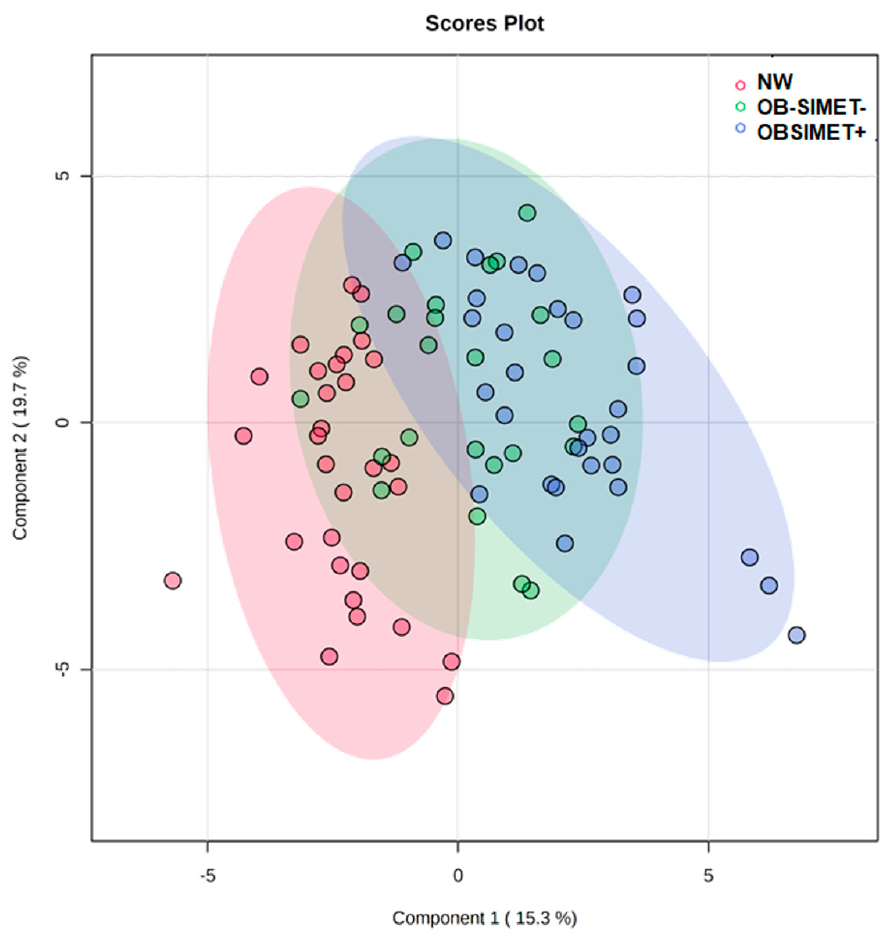
Figure 1. Comparison of the circulating lipidome in normal-weight (NW) and obese subjects without (OB-SIMET − ) or with (OB-SIMET+) metabolic syndrome. Multivariate analysis—visualized as partial least squares discriminant analysis (PLS-DA)—of lipids in plasma for the three groups was used. The VIP scores (Figure 2), derived from PLS-DA, were used for ranking the dis- criminating features, taking a cut-off value > 1.0. From this analysis, a specific cluster of 15 sphingolipids endowed with high discriminating performance, hereinafter called discriminant sphingolipids, was identified as capable of marking univocally the differences among the three groups. In Figure 3, discriminant sphingolipids are visualized by heatmaps, evidencing clear- cut differences among NW, OB-SIMET − and OB-SIMET+ subjects. In some sphingolipid families, the different features showed a consistent pattern, i.e., a general decrease in plasma levels of HexCers, LacCers, and GM3 (with some exceptions), and a general increase in plasma levels of DHCers (with some exceptions), and sphingoid bases from lean to obese states. By contrast, the individual Cer species showed an opposite trend, some of them “ in crescendo ” and some of them “ in diminuendo